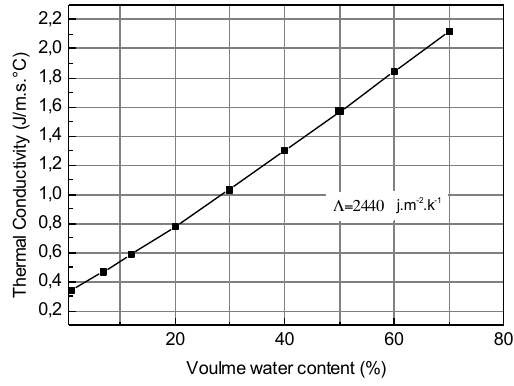
Figure 5a. Water retention curve (Case Study)